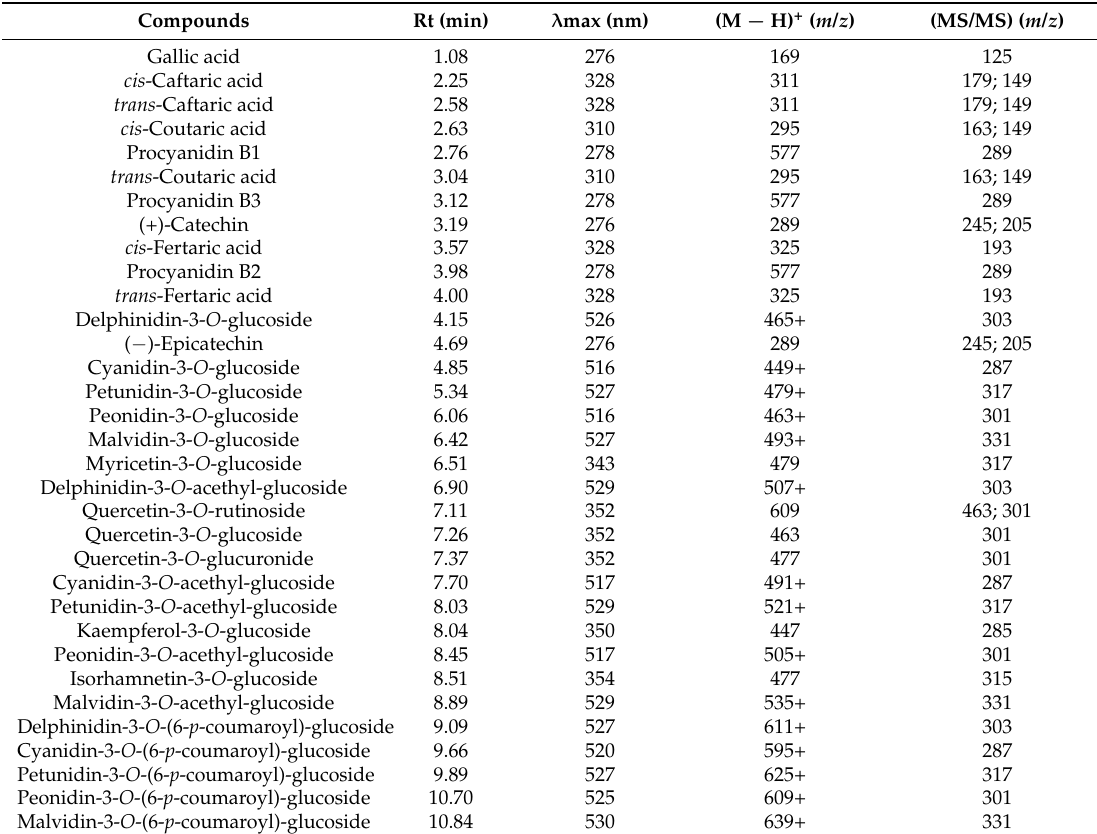
Table 3. Characterisation of phenolic compounds of vine grape fruits by retention time, λ max and negative and positive ions using ultra-pressure liquid chromatography with photodiode array and mass spectrometry